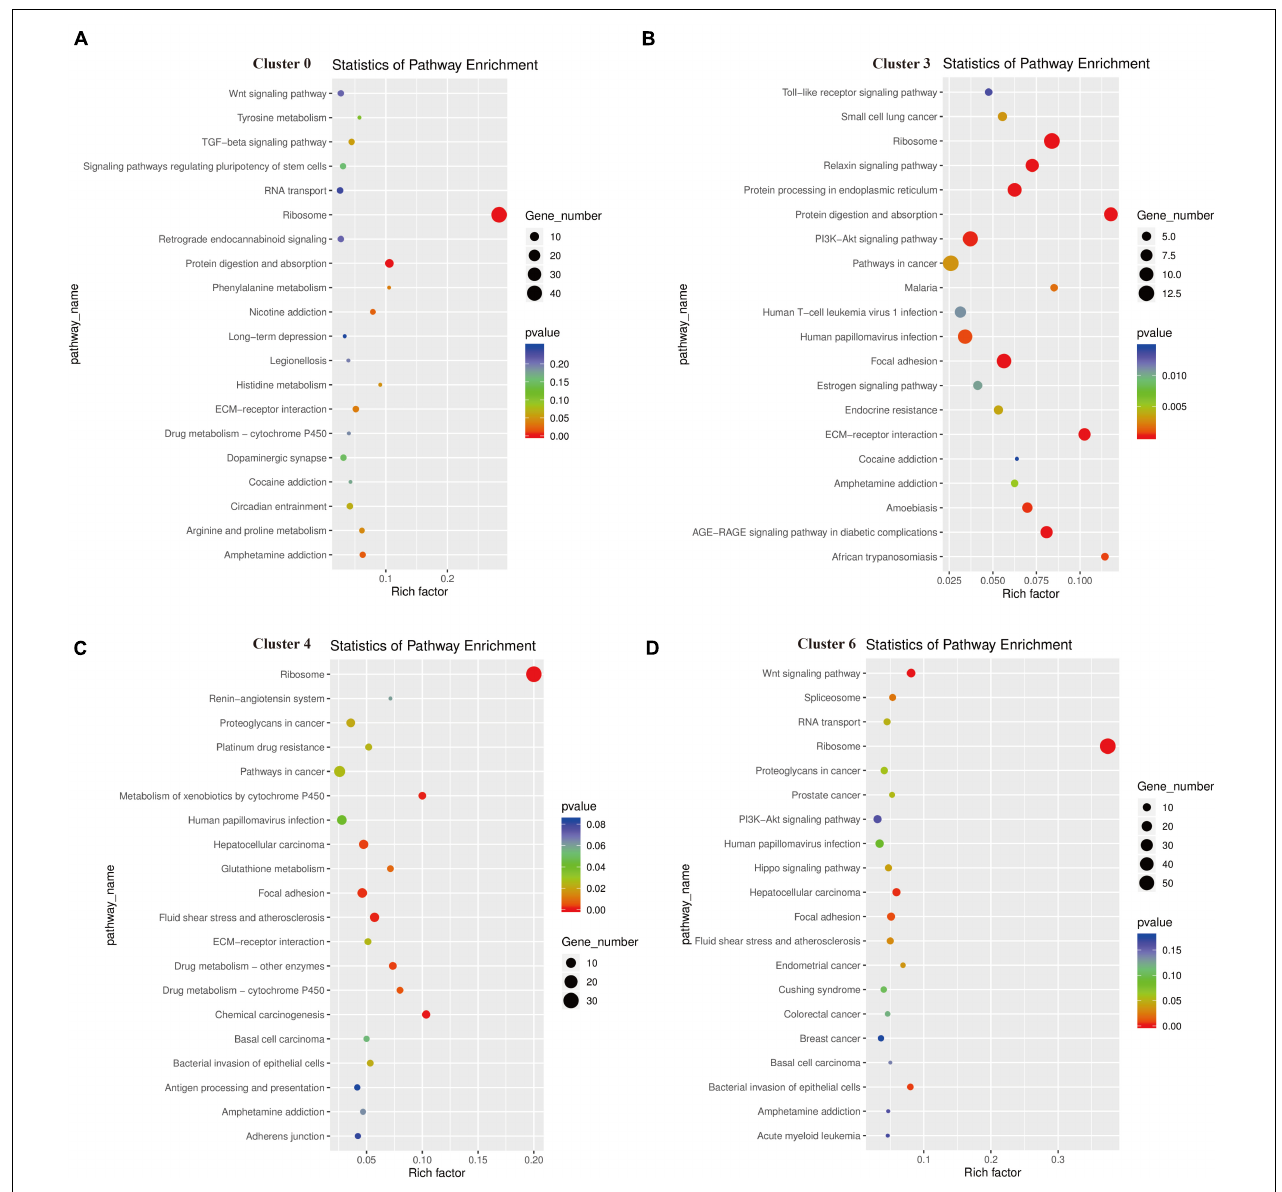
FIGURE 7 | Functional enrichment analyses using Kyoto Encyclopedia of Genes and Genomes (KEGG) pathways for cluster 0 (A) , cluster 3 (B) , cluster 4 (C) , cluster 6 (D) . The triangle size indicates the significance and corresponding significance values displayed as log10 ( P -value).